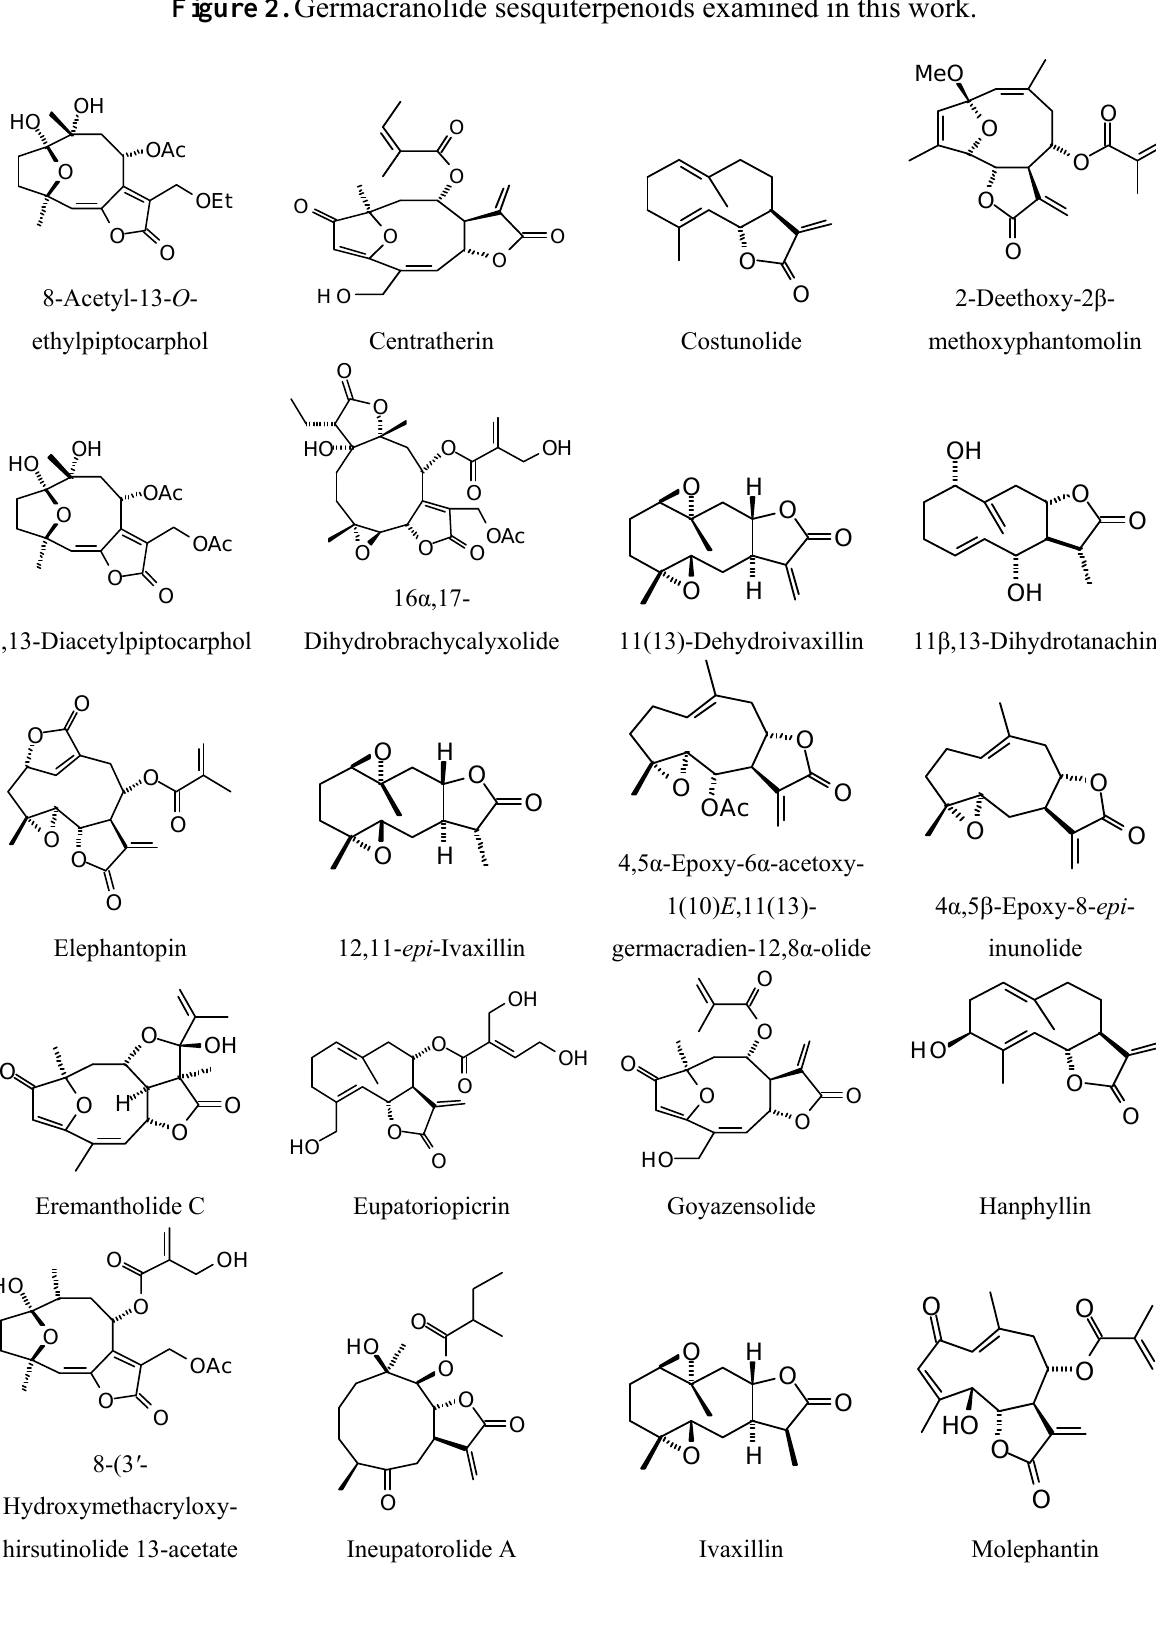
Figure 2. Germacranolide sesquiterpenoids examined in this